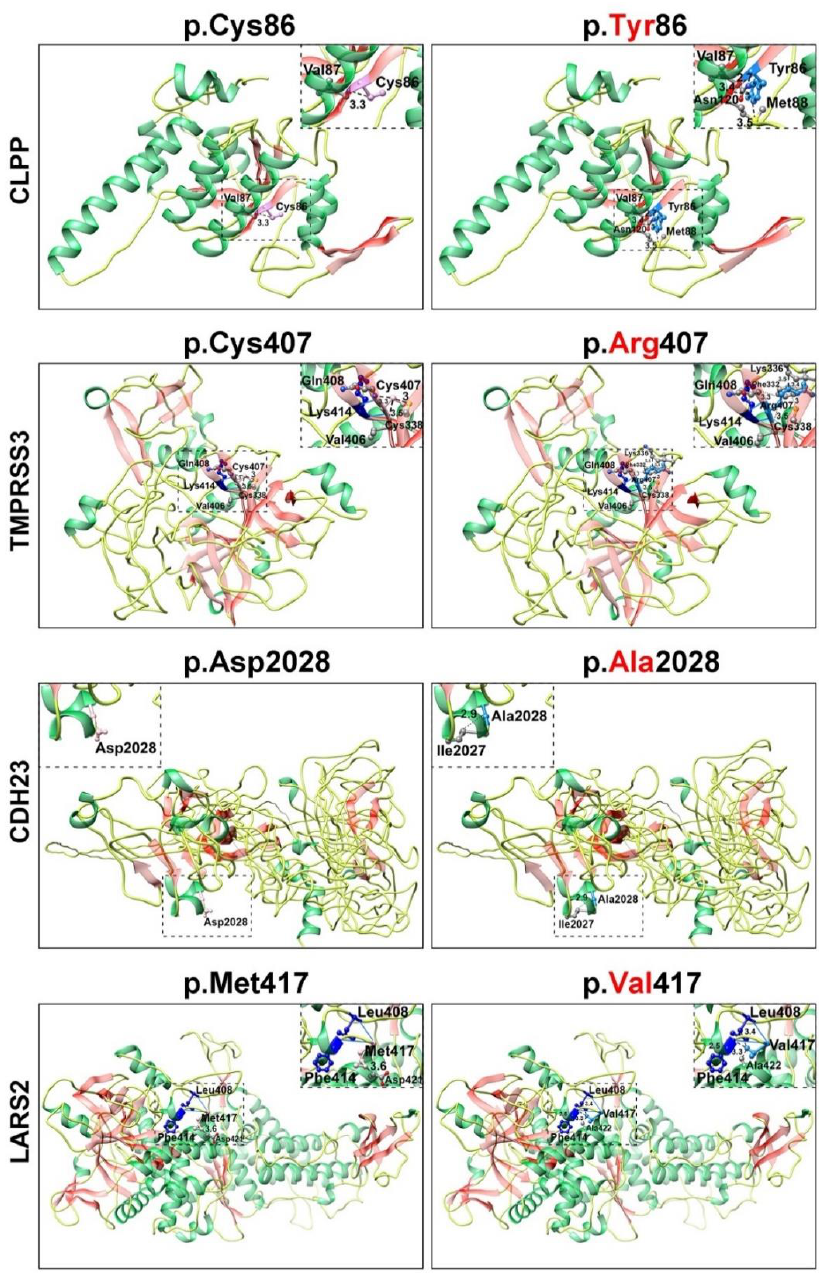
Figure 3. Protein 3D secondary structures generated by Phyre2 are shown in the respective colors: helix, green; strand, reddish pink; and coils, yellow. Pink and Dodger blue colors are used to show wild-type and mutant amino acids, respectively. Hydrogen bonding is shown by solid blue lines and concerned amino acids in dark blue color. Dotted lines represent the distance of the amino acids of interest with nearby residues in Angstroms respect. However, nearby residues are shown in color by element. The differences in size, charge, and hydrophobic properties of cysteine versus tyrosine at position 86 of CLPP might impact the interactions with other molecules on the surface of the protein. Similarly, the p.(Cys407Arg) missense substitution in TMPRSS3 is predicted to impact the core of the protein due to the larger size and different hydrophobic properties. The p.(Asp2028Ala) change mutates the calcium-binding motif (LDRE) of the cadherin repeat in CDH23, and causes a loss of interaction with the p.(Glu2030) residue. Finally, the p.(Met417Val) missense variant of LARS2 is predicted to induce aberrant ionic interactions with p.(Leu408).